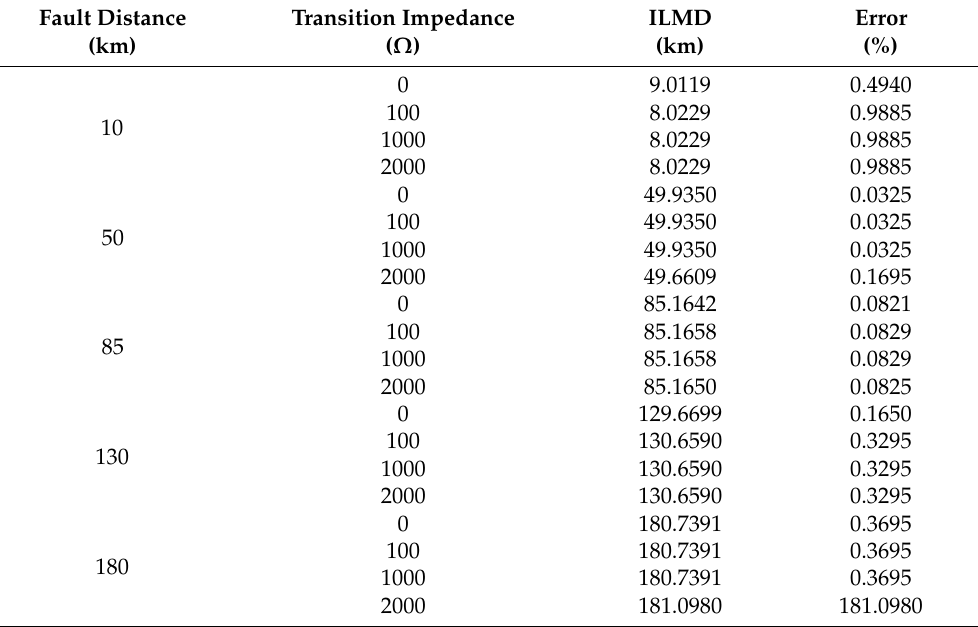
Table 2. Algorithm ranging accuracy verification under different transition